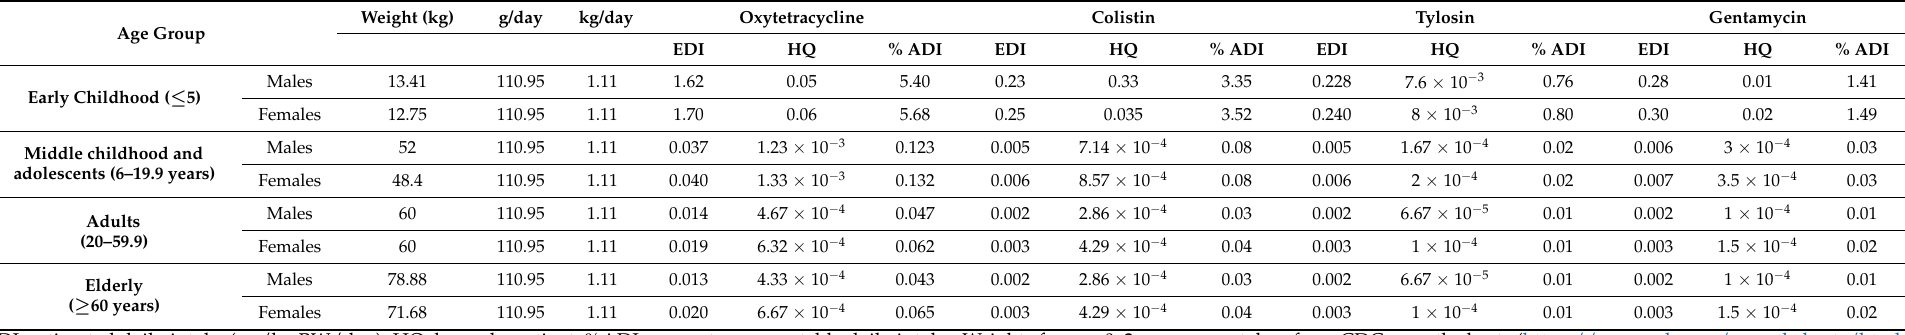
Table 7. Risk characterization of dietary exposure to antibiotic residues through consumption of milk among various age groups using the probabilistic